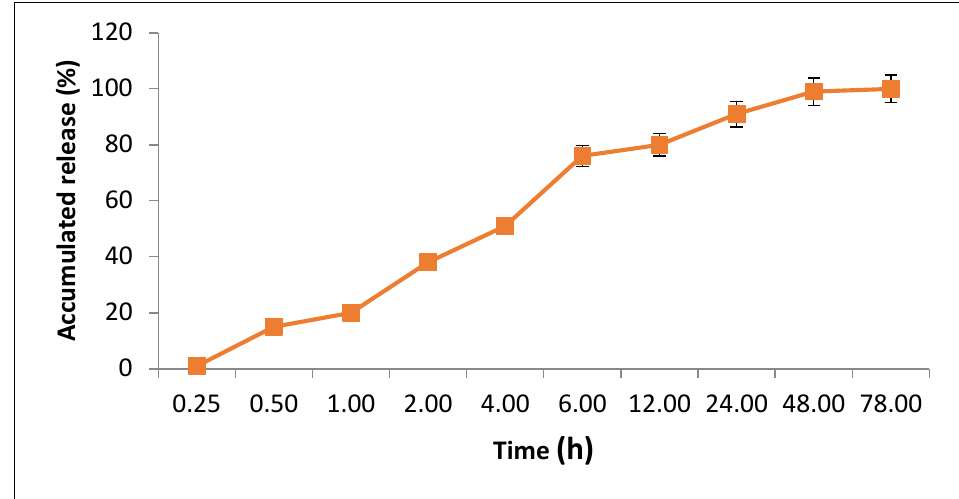
Figure 5. AgNPs release behavior from the AgNPs-SM/PVA nanofiber.